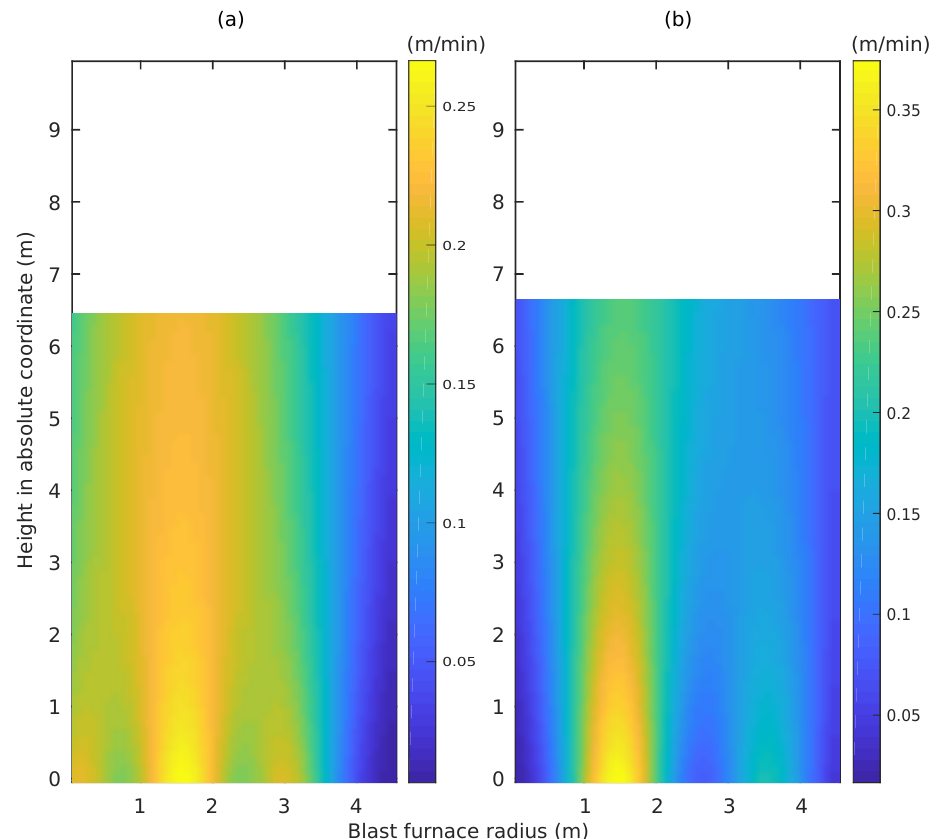
Figure 7. EBDFs from two data segments. ( a ) EBDF corresponds to Case 1; ( b ) EBDF corresponds to Case 2.